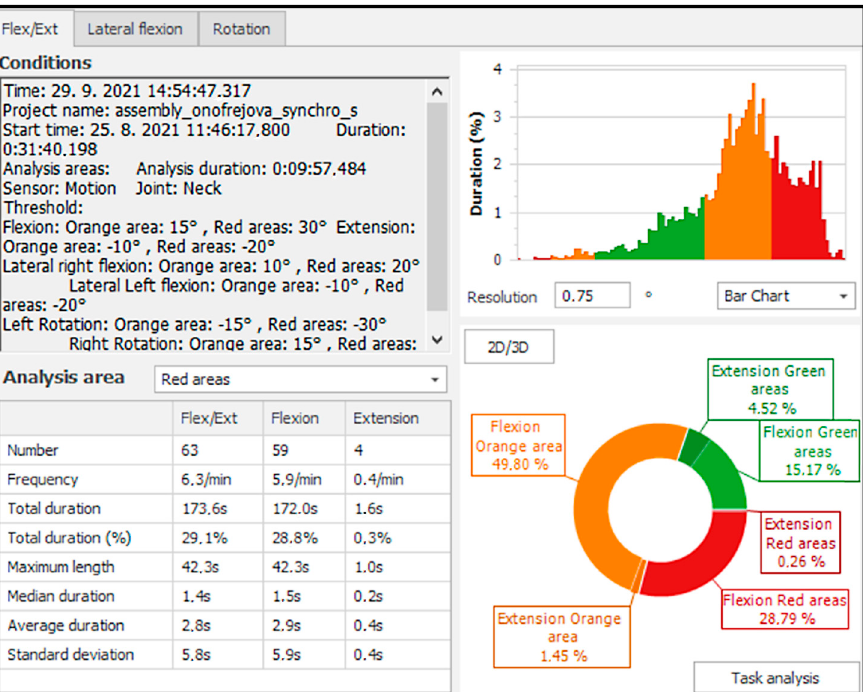
Figure 4. Detailed results of time duration in individual postures, in experiments with one worker using exoskeleton: Neck Flexion/Extension.